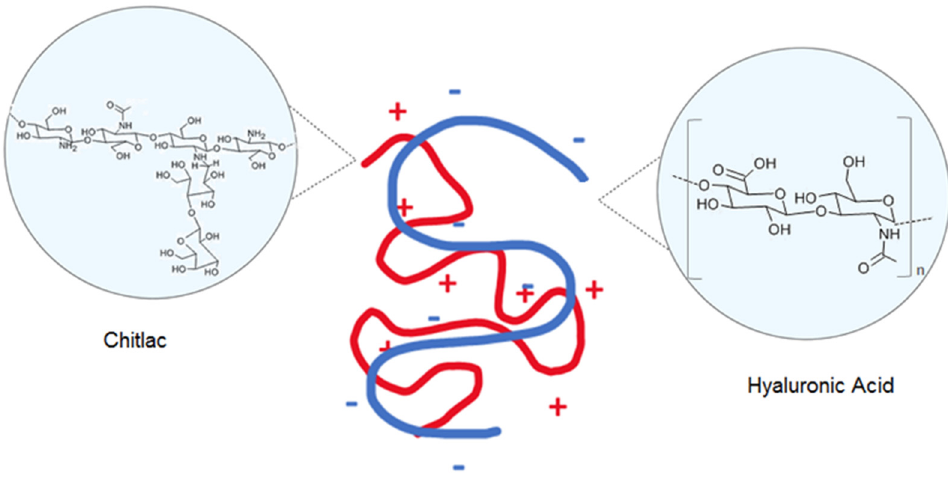
Figure 1. A schematic representation of the interaction between Hyaluronan (HA) and Chitlac (CTL). The aims of this study were (1) to assess and compare the expression of pro-inflammatory markers, MMPs and ECM molecules in primary human dermal fibroblasts derived from a young and middle-aged woman donor; (2) to evaluate ECM molecule production by primary human dermal fibroblasts stimulated with HA and CTL; finally, (3) to assess and compare the production of ROS, the expression of pro-inflammatory molecules, MMPs and ECM molecules in primary human dermal fibroblasts incubated with a macrophage-derived inflammatory stimulus in the presence/absence of HA and